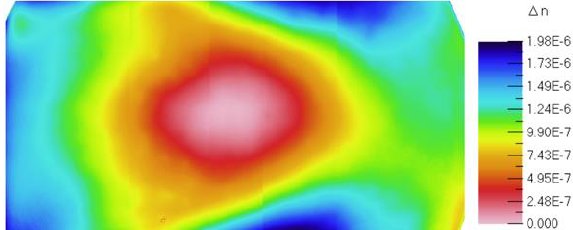
Fig. 3. Representative interferometric measurement of the refractive index of a SCHOTT N-BK7 ® jumbo strip with an aperture of approx. 800 x 400 mm 2 in false color code. The low peak-to-valley index variation achieves 1.98 ppm